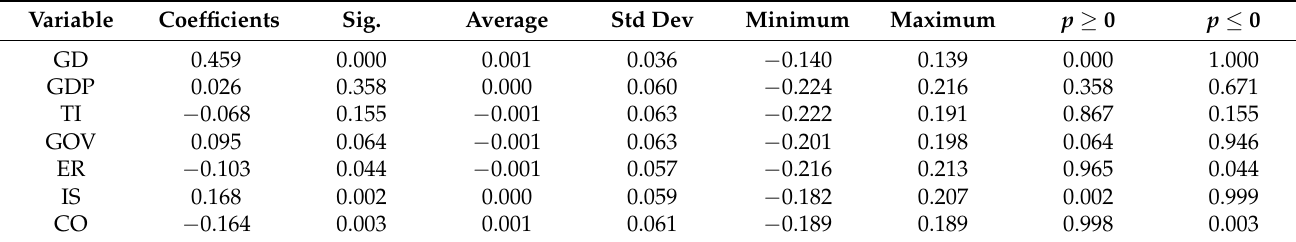
Figure 5. Correlation between the four blocks. Table 5. Results of the QAP correlation